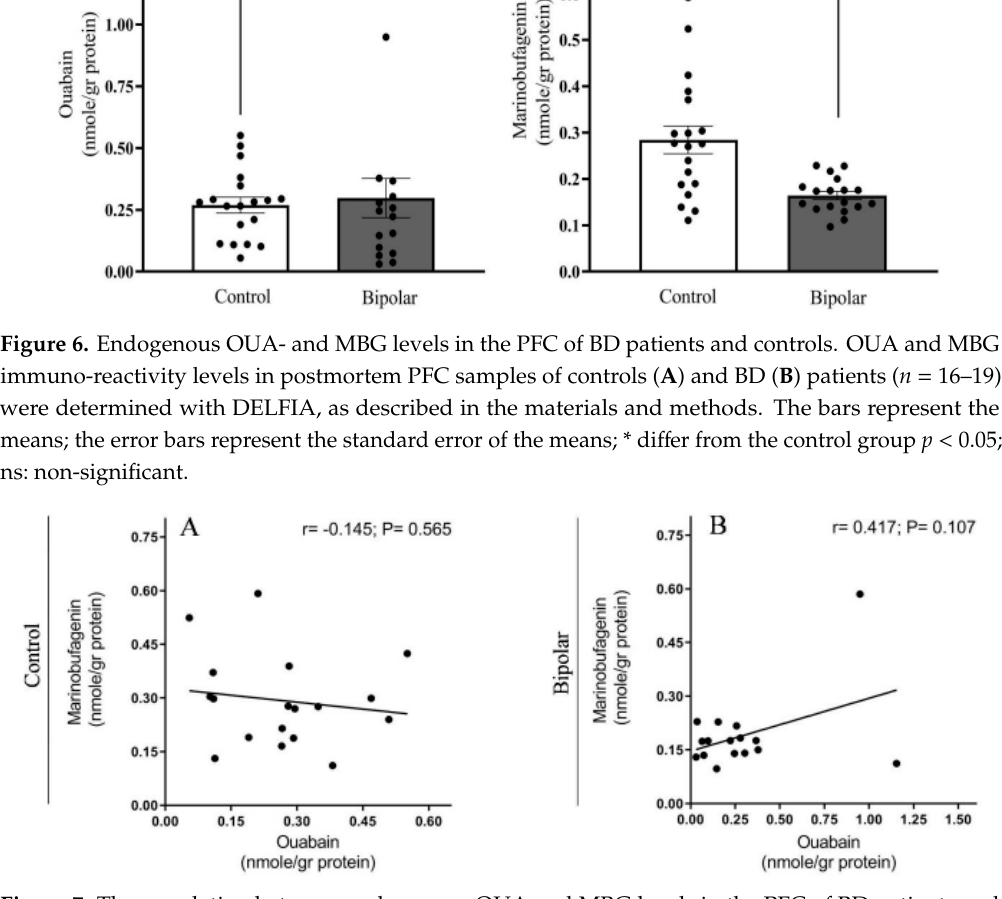
Figure 8. The correlation between the α 1 isoform levels and endogenous OUA and MBG immuno- reactivity in the PFC of BD patients and controls. The levels of the α 1 isoform of the Na + , K + -ATPase (Figure 1) and OUA and MBG immuno-reactivity (Figure 3) in BD patients ( C – D ) and controls ( A – B ) were correlated. The Pearson correlation coefficient ( r ) and the p value (two tailed) were calculated by using correlation analysis (GraphPad Prism v 8.3.1).